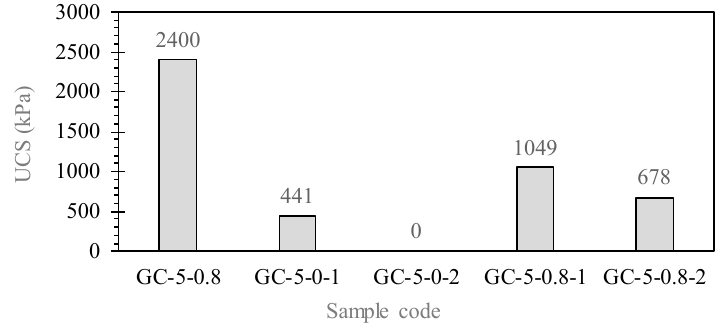
Figure 7. Unconfined compression strength of the granitic–cement samples. 258